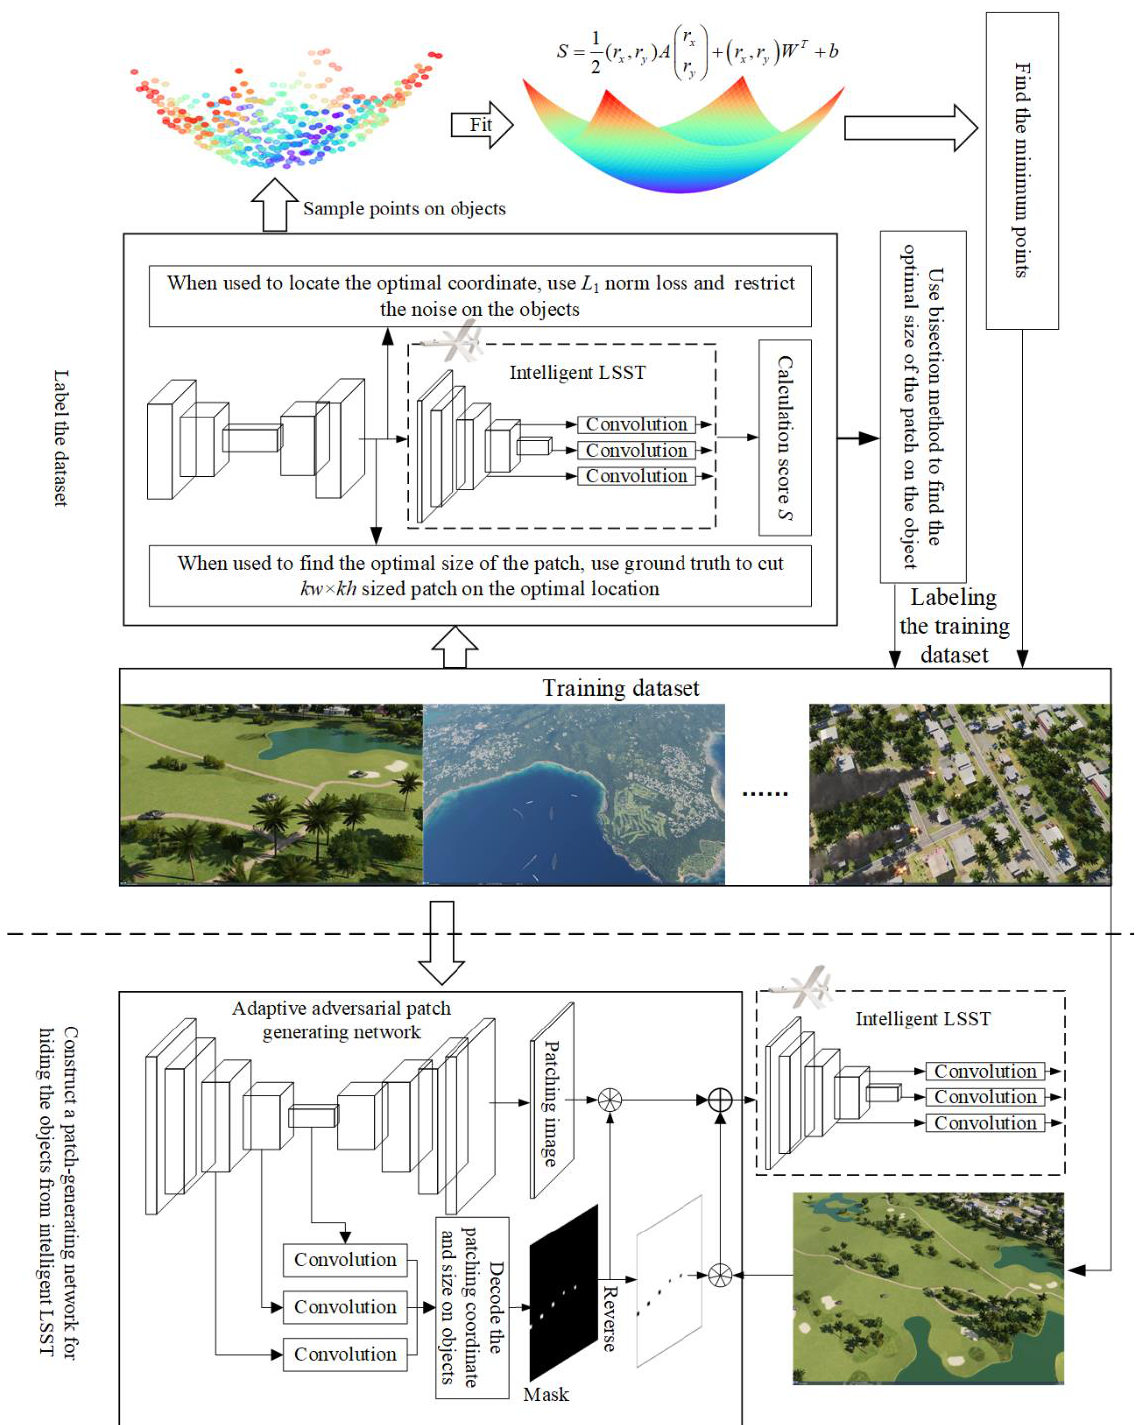
Figure 1. The structure of our algorithm. The upper part is the data labeling process which labels the objects in the dataset with the optimal location and size of the patch. The lower part is the patch- generating network which uses the labeled dataset to train a model that can generate a patching image and a mask for an input image. The mask is used to select the areas from the patching image and patch the selected areas to the objects.